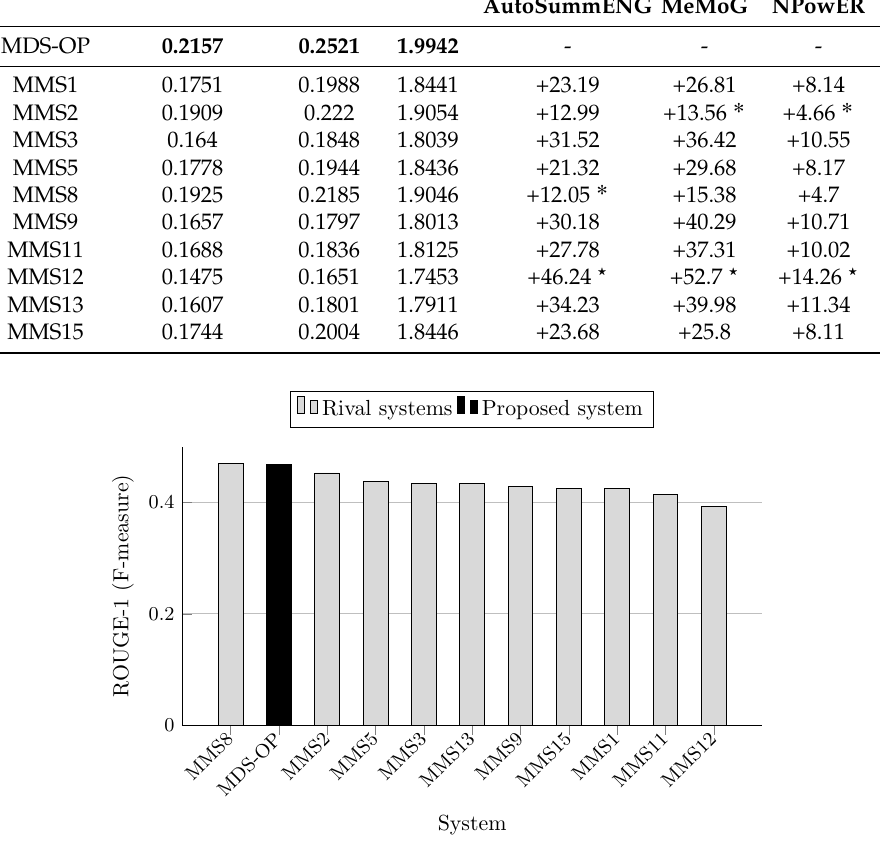
Figure 9. ROUGE-1 scores (F-measure) on MultiLing 2015 (MMS